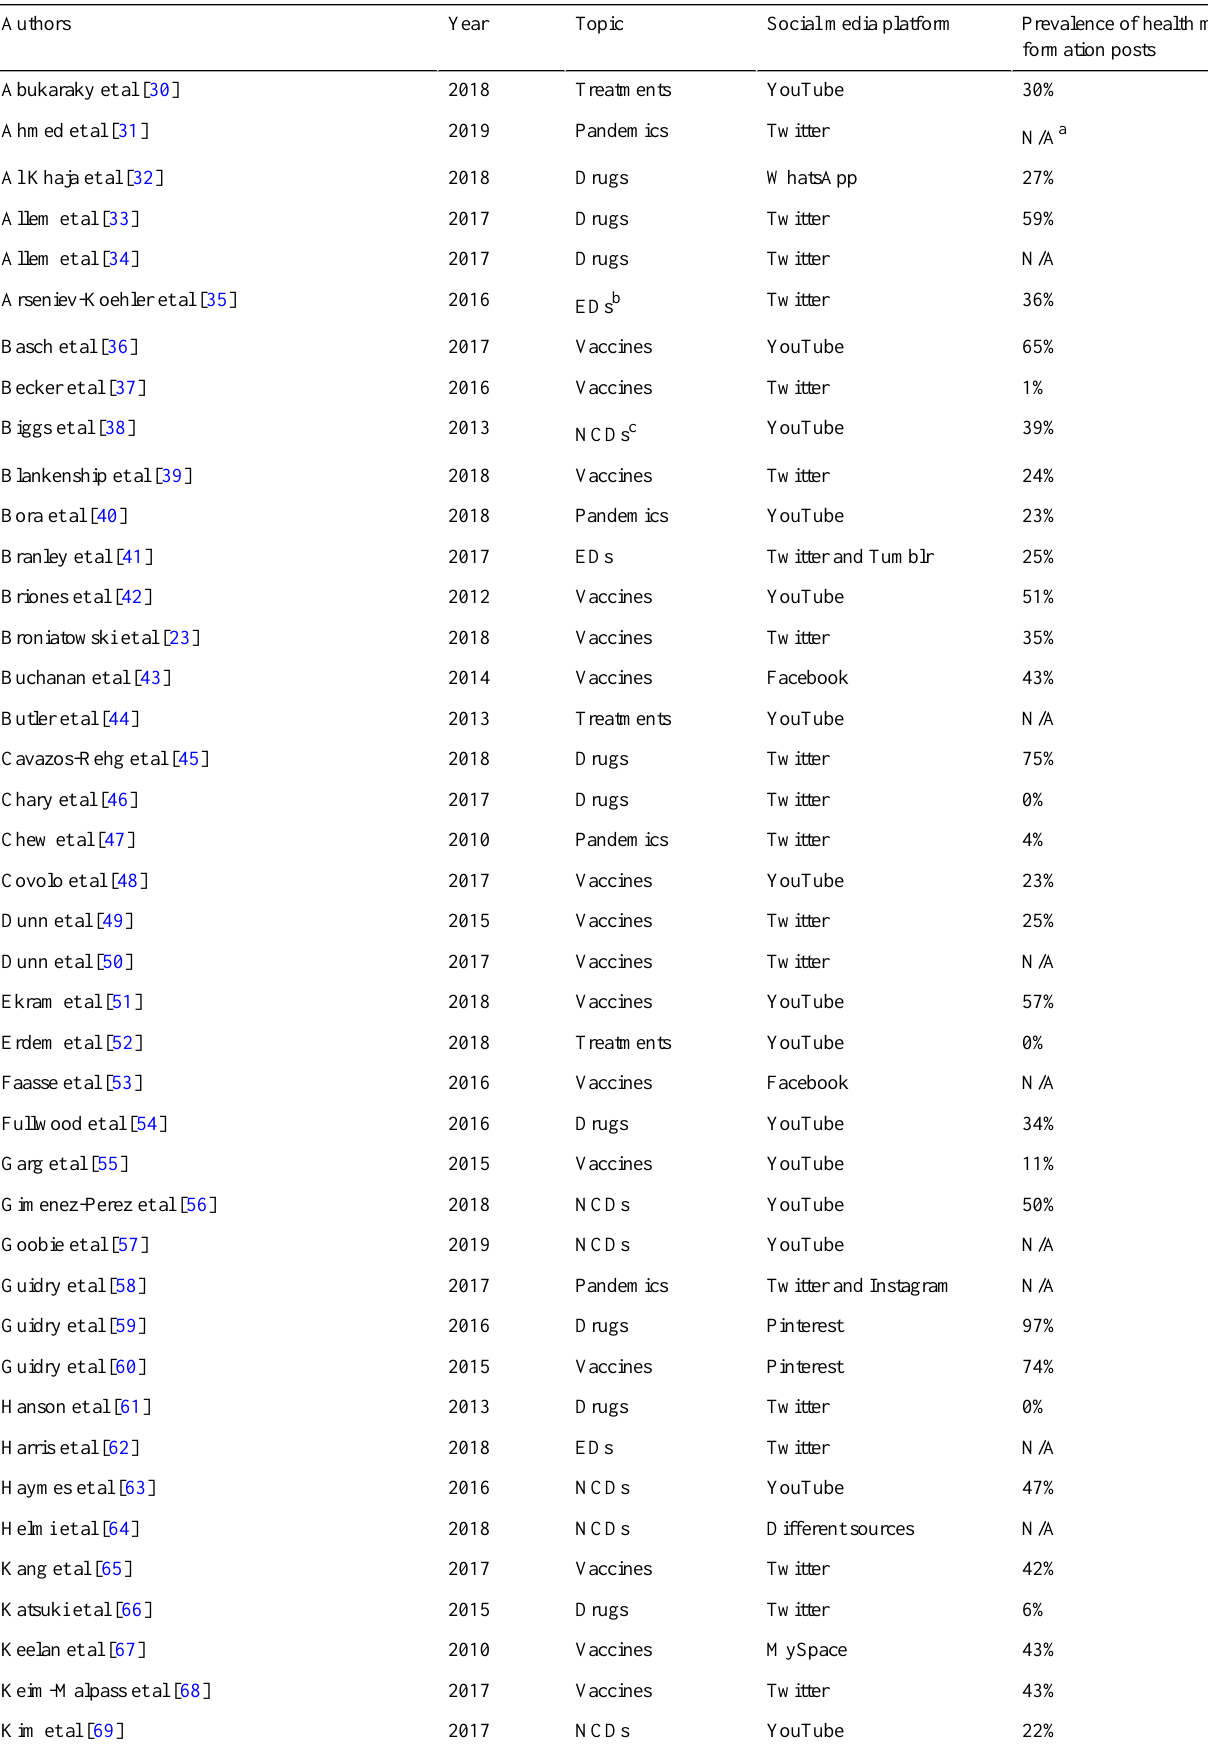
Table 1. Summary of the prevalence of misinformation by topic and social media platform.